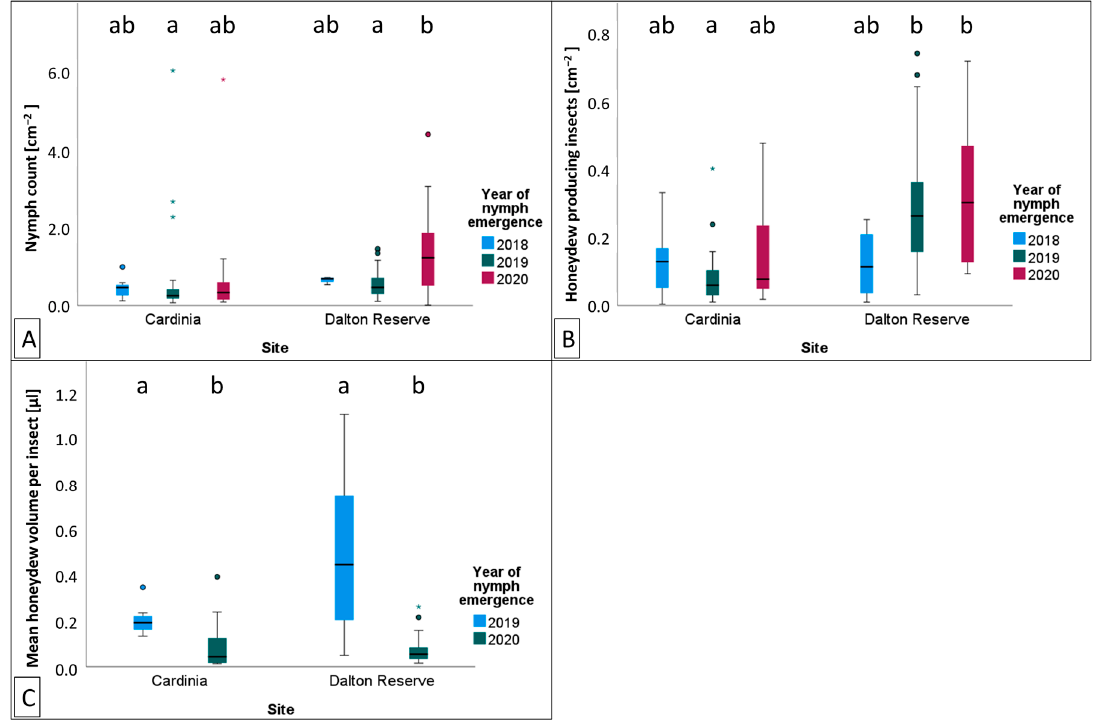
Figure 5. Box and whisker plots of Marchalina hellenica population activity at Cardinia or Dalton Reserve during the 2018, 2019 or 2020 emergent generations. Marchalina hellenica activity illustrated includes ( A ) nymph count per cm 2 , ( B ) honeydew producing insects per cm 2 , and ( C ) mean honeydew volume excreted per insect [ μ L]. Box and whisker boxes represent interquartile ranges, with the horizontal black line within the boxes indicating the group mean. Outliers are indicated by circles and asterisks. Significant differences between groups are indicated by different letters ( p < 0.05).